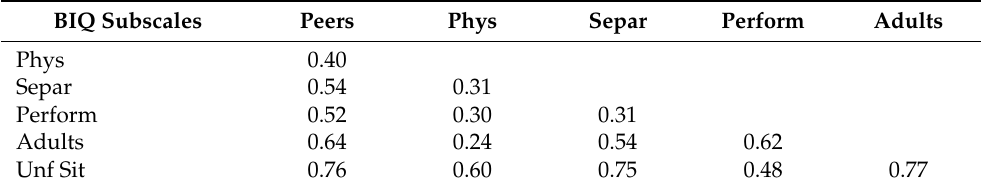
Table 8. Heterotrait-Monotrait Ratio of Correlations (HTMT)